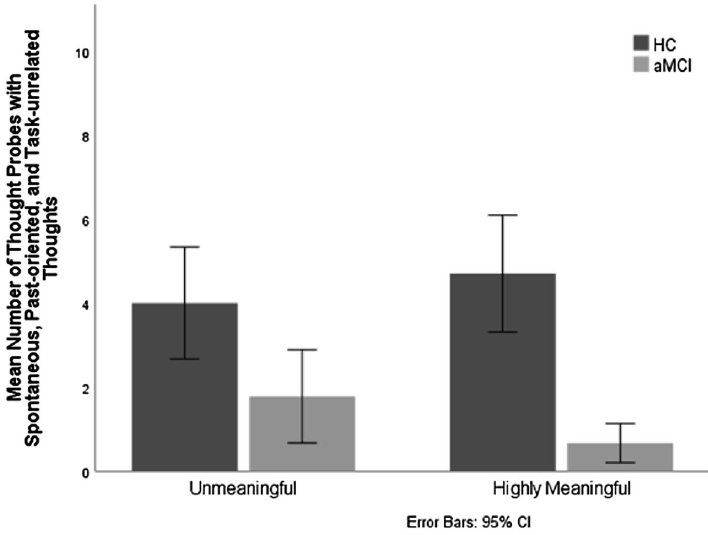
Figure 4. Mean number of thought probes with spontaneous, past-oriented, and task-unrelated thoughts as a function of stimulus type (highly meaningful vs unmeaningful) and group (aMCI participants vs. healthy controls).